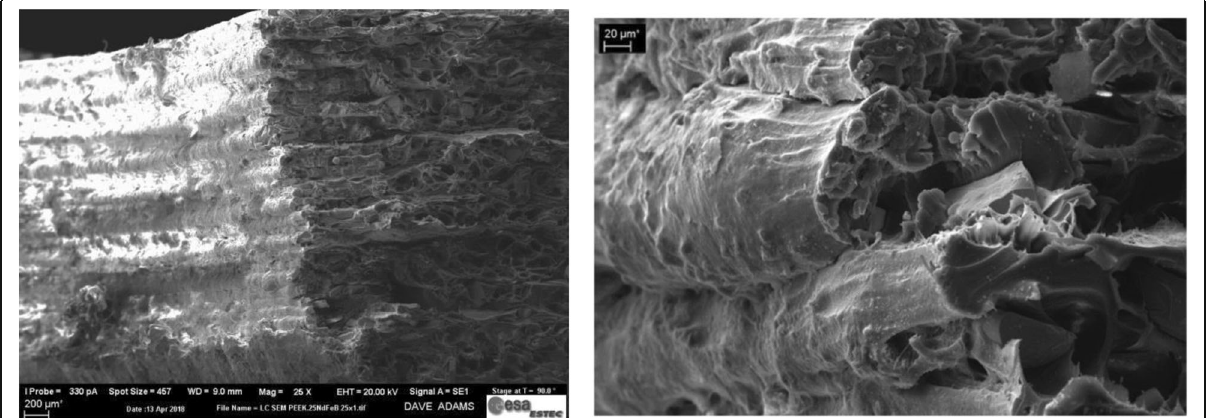
Fig. 13 3D printed PEEK_25NdFeB (right) surface fracture after tensile testing. Detail of layer